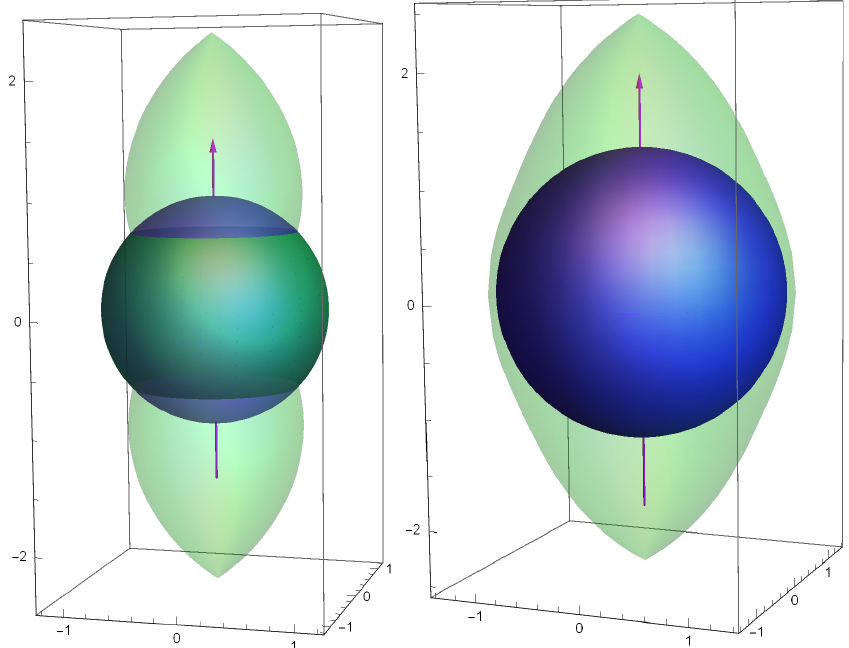
(cid:113) √ √ 2,0, 11 + 8 2 ) —fully spherical (cid:113) √ √ 2, − 6, 16 2 − 13 ) and ( r , λ , q ) = ( 4, − 7,0 ) —counter-rotating photon